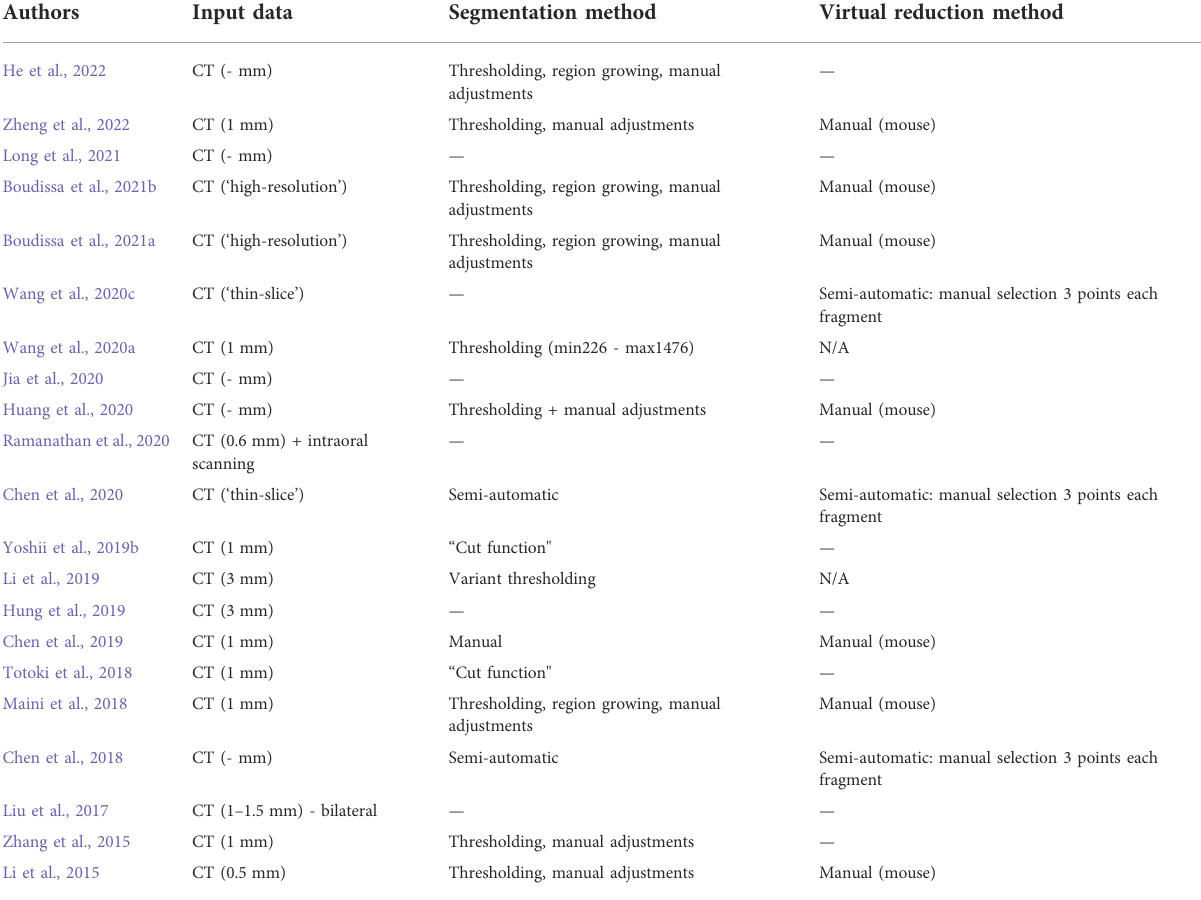
TABLE 3 Simulation methods used in 21 included studies. -: Not speci fi ed. N/A: Not applicable.